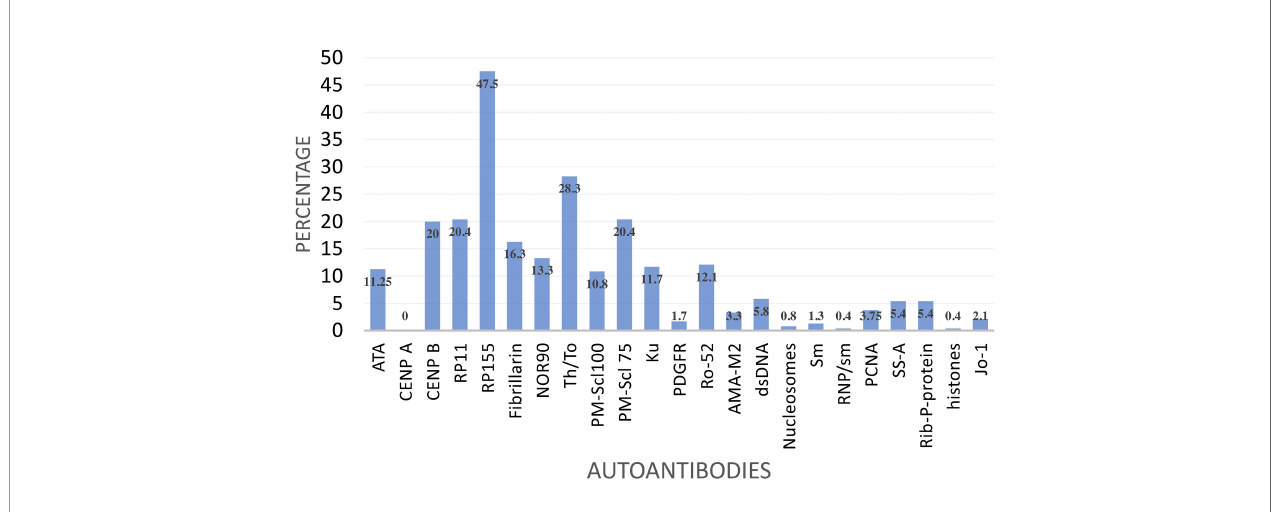
FIGURE 1 | Frequency of reactivity to a panel of selected autoantibodies by SSc speci fi c autoantibody reactive